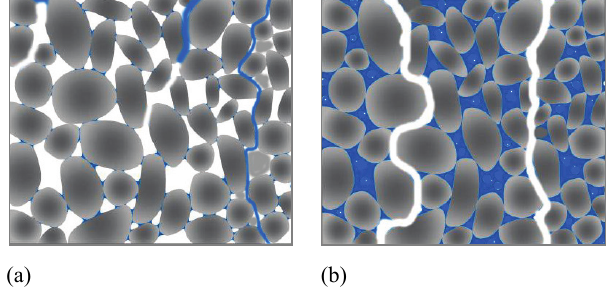
Fig. 5. Schematic representation of possible micro-structure of saturation during constant suction tests: (a) wetting phase (b) drying